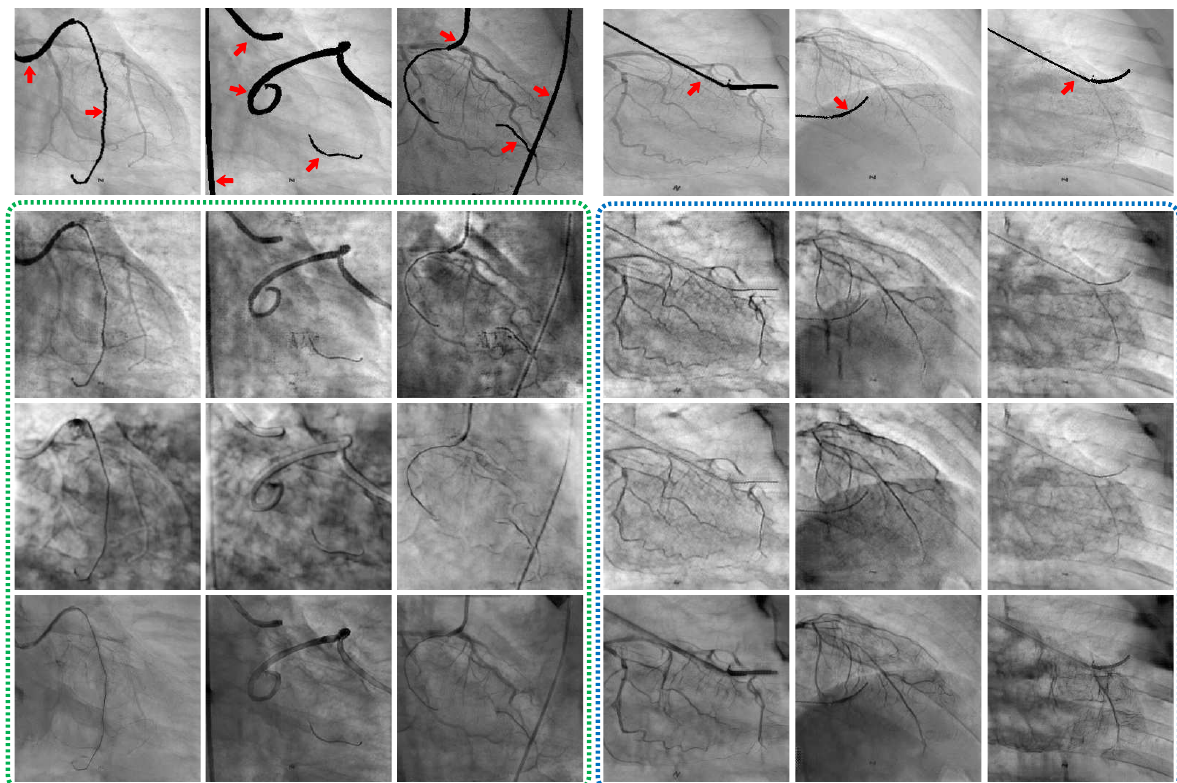
Figure 6. From top to bottom: inputs, U-Net L cyc , ResNet L cyc and ResNet L cyc + L perp . (Red arrows) highlight the initial position of the composited catheter in X-ray angiograms and with the generated images using different methods presented in each subsequent rows. Synthetic catheters are represented with green dotted region, whereas the camera catheter is shown in the blue dotted